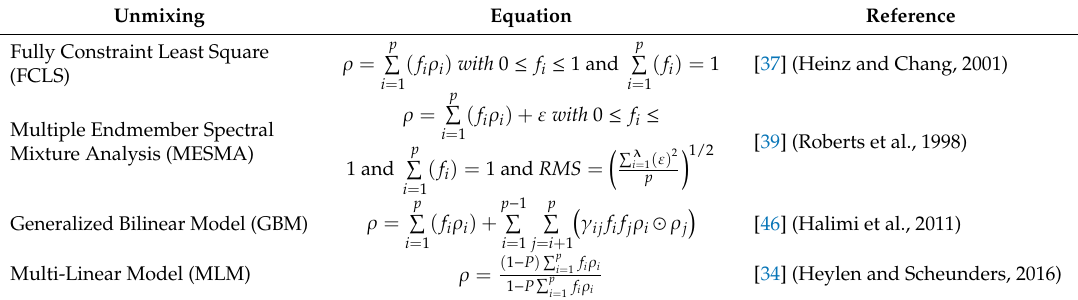
Table 3. Unmixing methods. Reflectance: ρ , number of endmembers: p, endmember abundance: f i